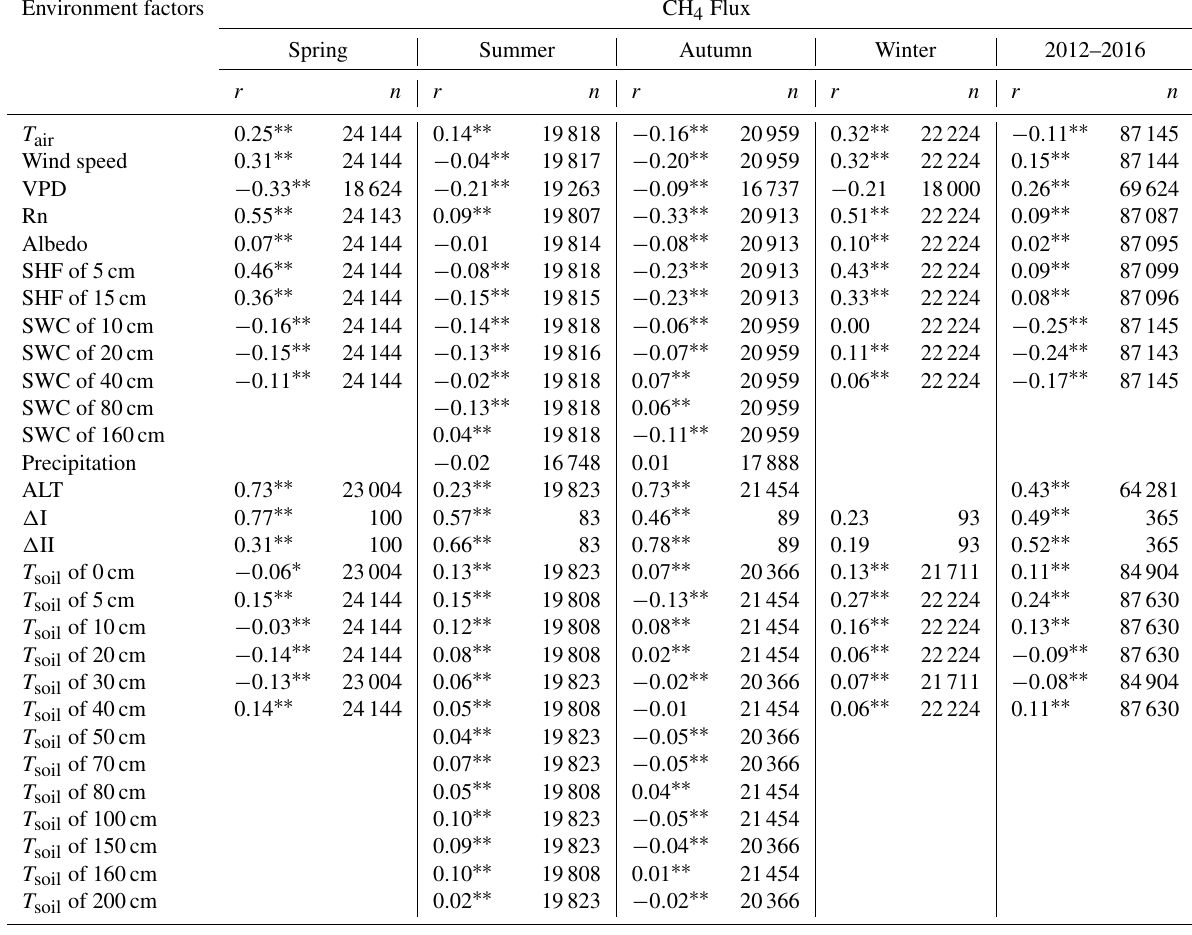
Table 3. Correlation coefficients between CH 4 fluxes and environment factors on half-hour timescales. Environment